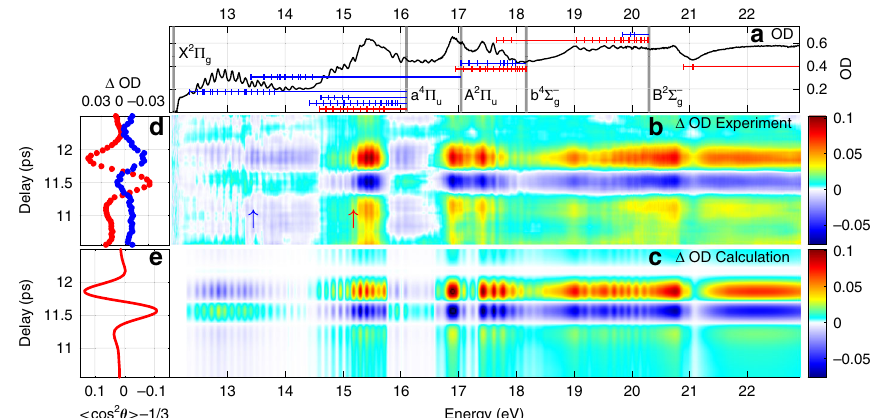
Fig. 3 Experimental and calculated XUV transient absorption in aligned O 2 . a Static absorption of isotropic O 2 molecules from 12 to 22.9 eV. The positions of vibrational levels of Rydberg series built on several O þ cores are indicated, parallel and perpendicular transition are labeled by red and blue lines 2 respectively. b Experimental and c calculated differential absorption spectra around the full revival of aligned O 2 molecules. d Modulations of the spectrum at 13.43 eV (blue circle) and 15.18 eV (red circle). e Calculated alignment degree < cos 2 θ > (cid:2) 1 = 3.